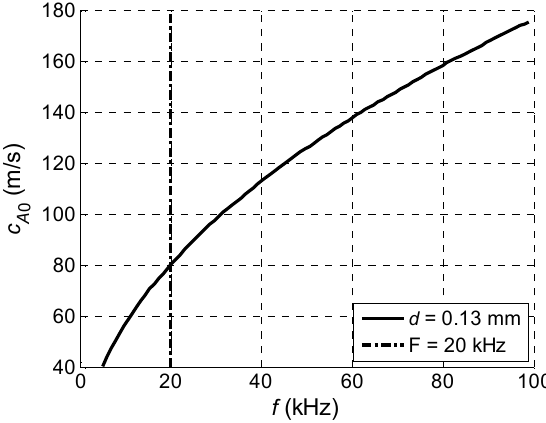
Figure 6. A 0 mode phase velocity c A 0 dispersion curve for the PVC film with d = 0.13 mm thickness.